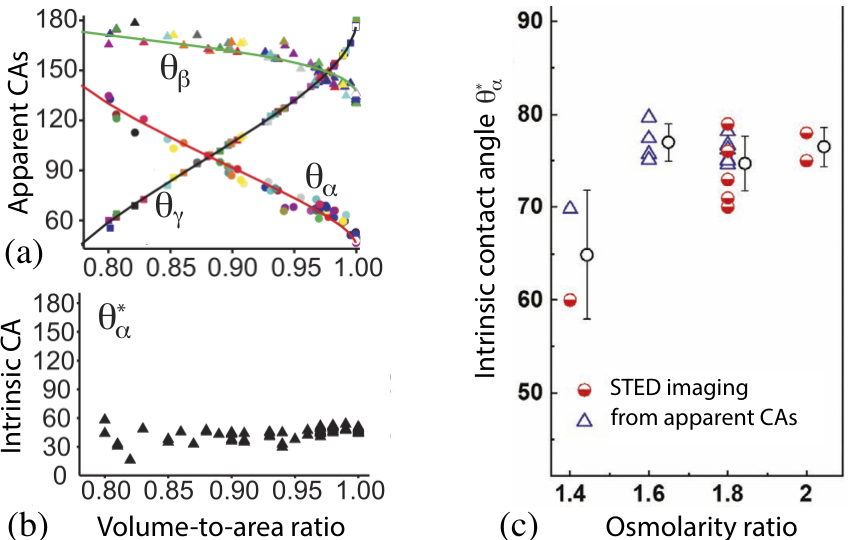
Figure 16. Experimental values of the intrinsic contact angle θ ∗ α : ( a ) Apparent contact angles (CAs) for a batch of 63 GUVs with different volume-to-area ratios v as defined by Equation (48) [5]; ( b ) The intrinsic contact angle (CA) θ ∗ α as obtained from the apparent CAs in panel a by using Equation (47), which leads to cos θ ∗ α = 0.714 ± 0.075 and θ ∗ α (cid:39) 44.4 ◦ ; and ( c ) Intrinsic contact angle θ ∗ α measured via STED imaging (half-filled circles) and compared to those calculated from the observed apparent contact angles via Equation (47) (open triangles)